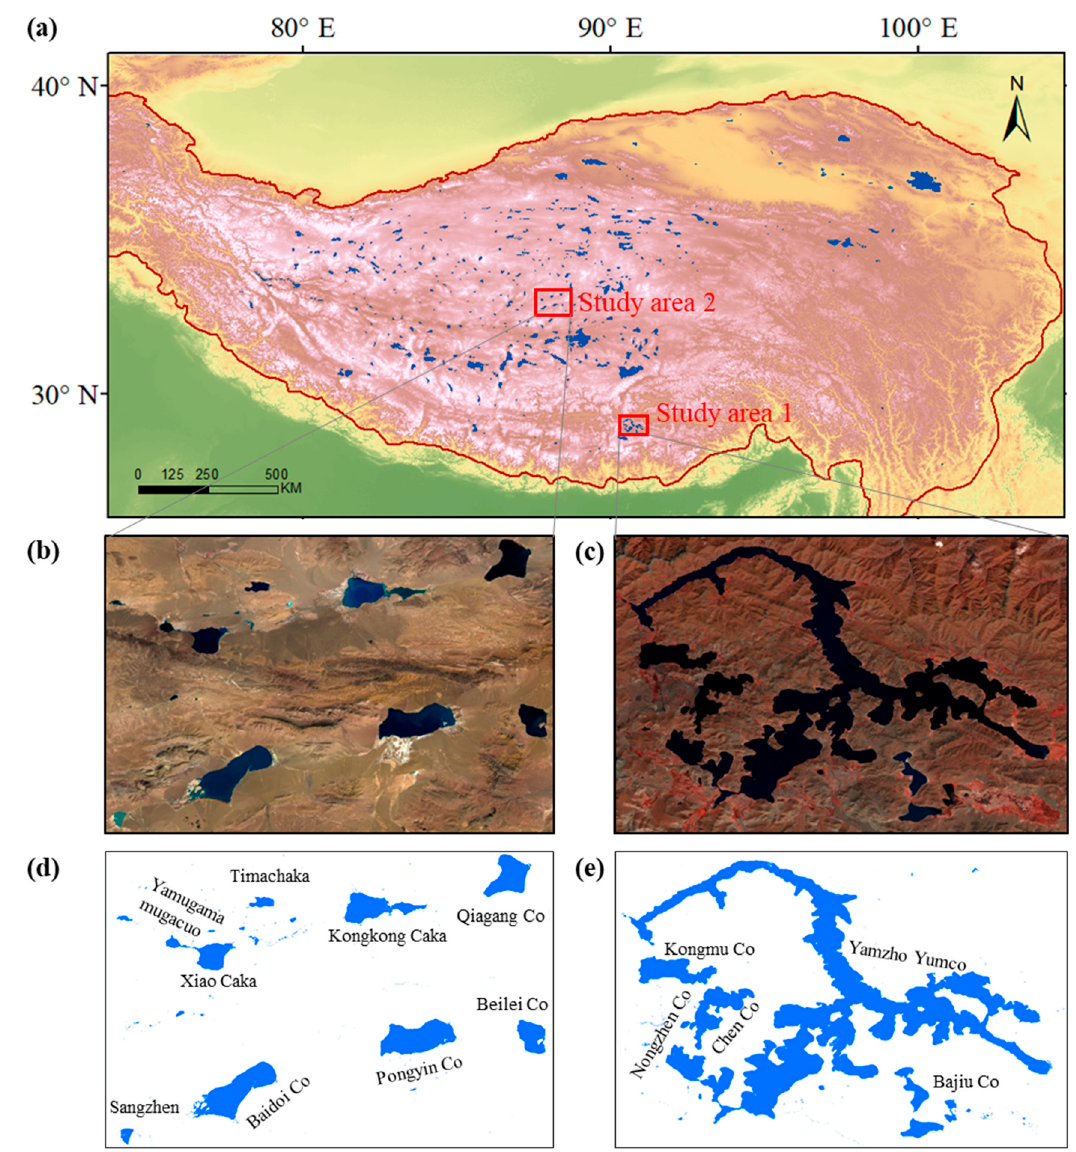
Figure 1. Study area map. ( a ) Tibetan Plateau (TP) area (the shapefiles of lakes are obtained from [29]), ( b ) Location of study area 2 shown in a color composite (R5G4B3) Landsat 8 OLI image, ( c ) Location of study area 1 shown in a color composite (R5G4B3) Landsat 8 OLI image, ( d ) Lake image derived from Landsat image of study area 2, ( e ) Lake image derived from Landsat image study area 1.